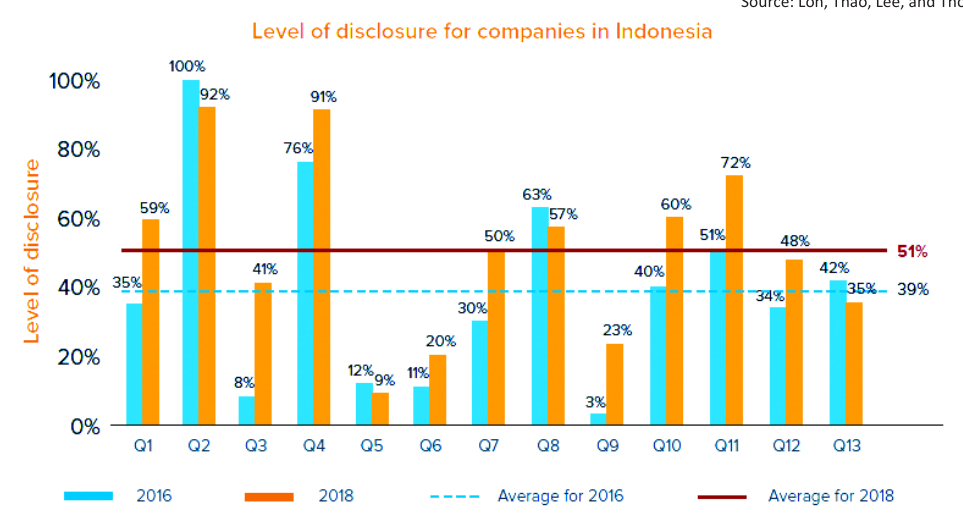
Figure 1. The levels of Indonesian companies disclosure